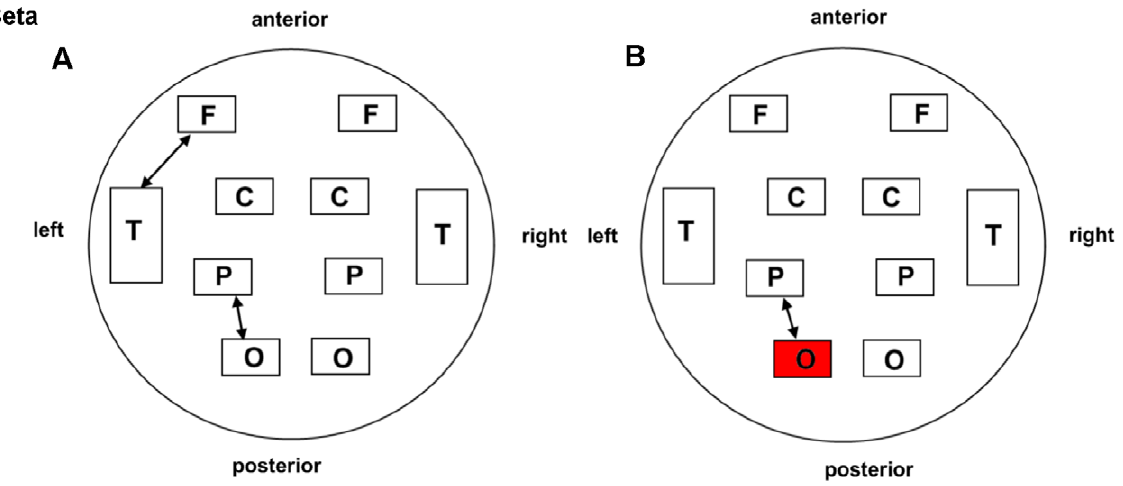
Figure 4. Schematic illustration of BLP correlation alterations for the beta band. A. ST36 group. B. NAP group. Lines correspond to significant changes for the average Band-Limited Power (BLP) correlation induced by acupuncture and squares to significant change in the local BLP correlation (red: local increase in the BLP correlation following acupuncture; thin line: P , 0.05; thick line: P , 0.01; significance is based upon a paired t -